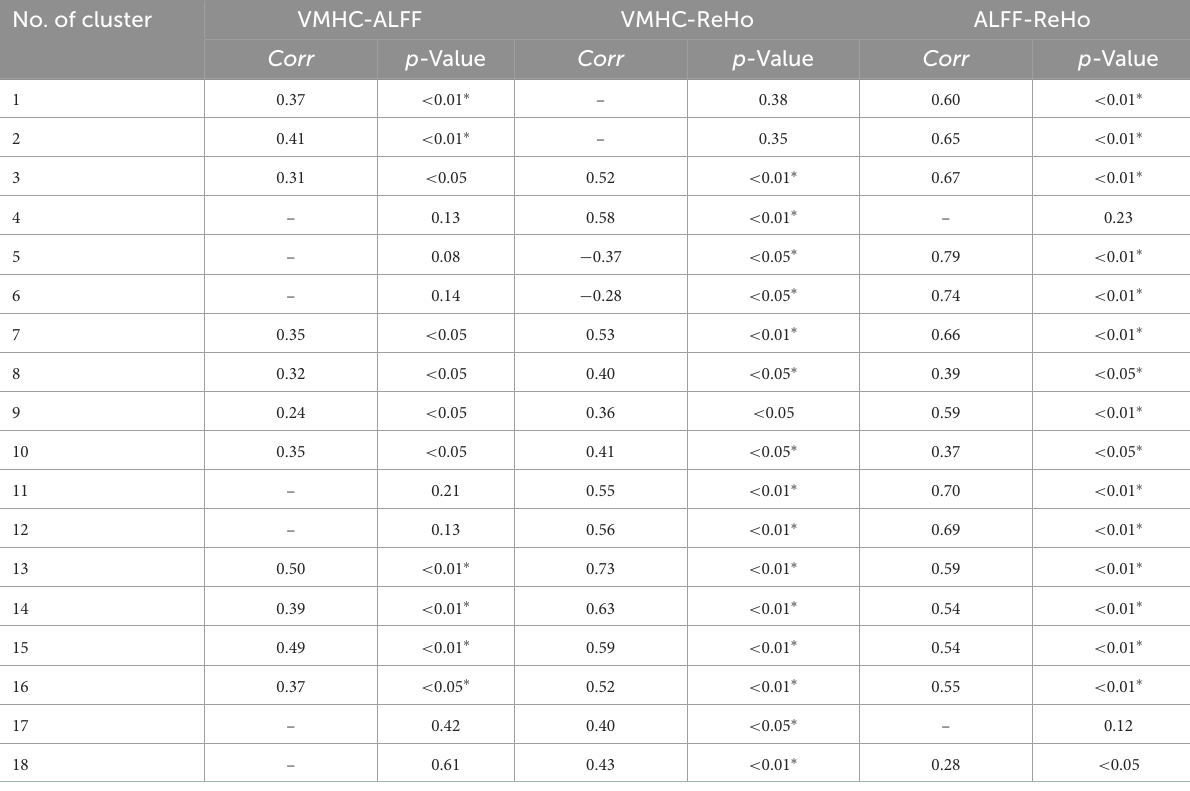
TABLE 3 Correlation coefficients among ALFF, ReHo, and VMHC in the brain regions showing significant differences. No. of